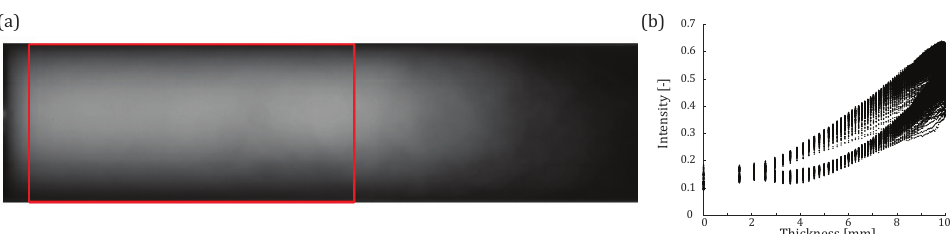
Figure 2. ( a ) Nonweighted vapor intensity at 1st peak length ( Re = 2239). The red box marks the region where the intensity–thickness correlation was evaluated. ( b ) Intensity–thickness scatter plot. Pearson’s correlation coefficient r = 0.88 ( p < 0.001). The main deviation between the variables is believed to be associated to the expected flow